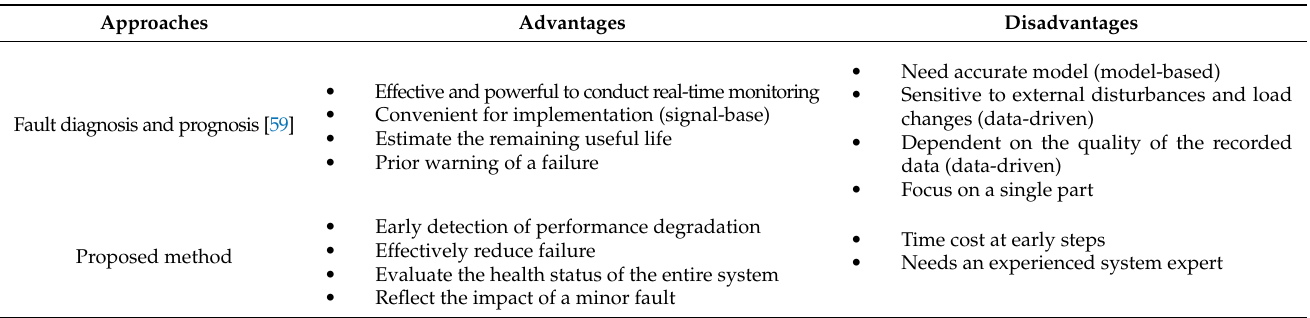
Table 3. Comparison of the fault diagnosis, fault prognosis, and proposed method.